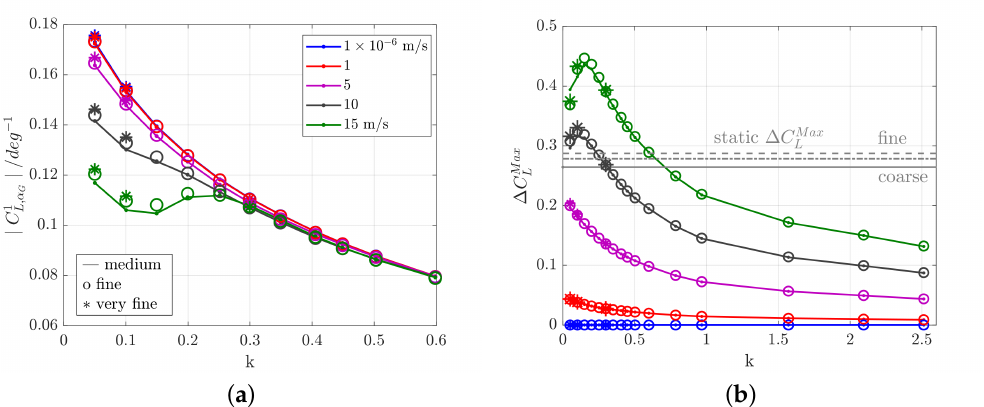
Figure A1. Comparison of three CFD meshes at Mach 0.70. ( a ) First harmonic of the lift FRF, ( b ) Maximum lift.